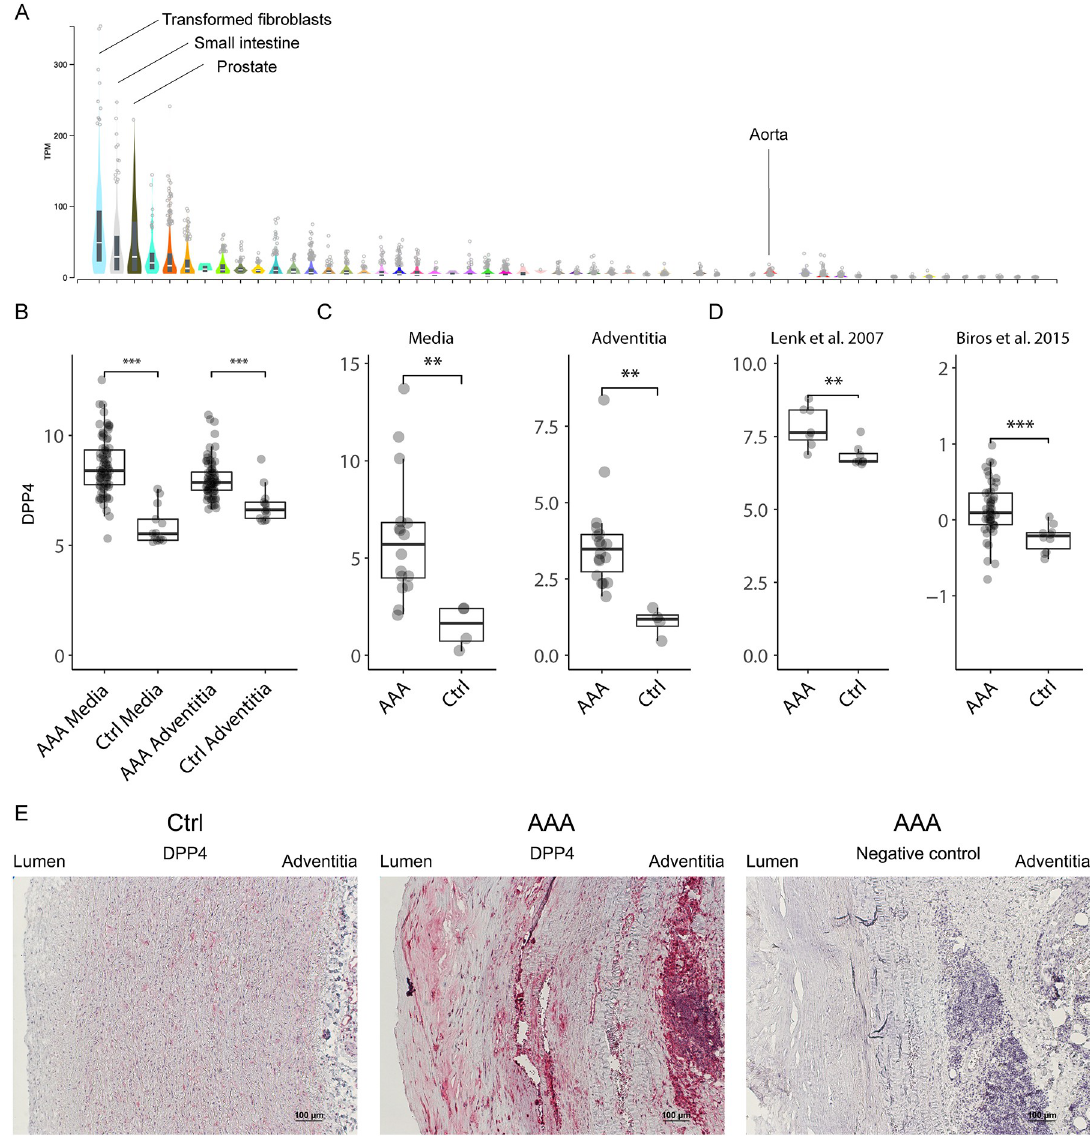
Fig 1. DPP4 expression in normal aorta and AAA. A: Normal DPP4 gene expression in different tissues, data from the genotype-tissue expression (GTEx) database, in which genome-wide gene expression is available from different disease-free tissues of hundreds of human donors. B and C: Gene expression of DPP4 as measured by microarray (B) and qPCR (C). D: Analysis of DPP4 gene expression data from two previously published microarray studies. E: Protein expression of DPP4 was analyzed with immunohistochemistry. Abbreviations: AAA; abdominal aortic aneurysm, Ctrl; controls. � ; p < 0.05, �� ; p < 0.01, ��� ; p < 0.001.